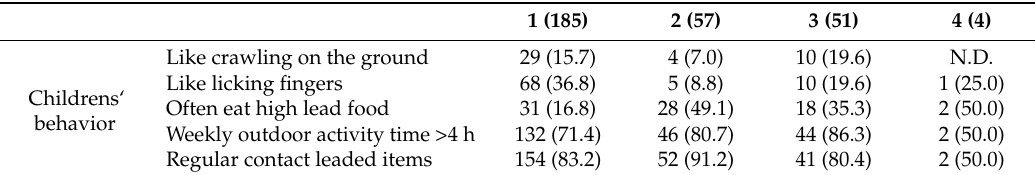
Table 6. The relationship between children’s behaviors and CBL.